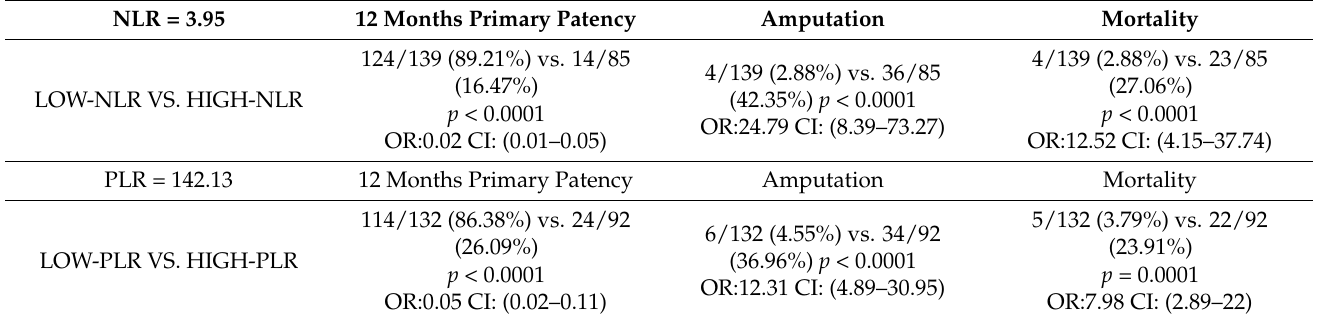
Table 5. Univariate analysis of NLR, PLR, and all adverse event occurrences during the study period for all